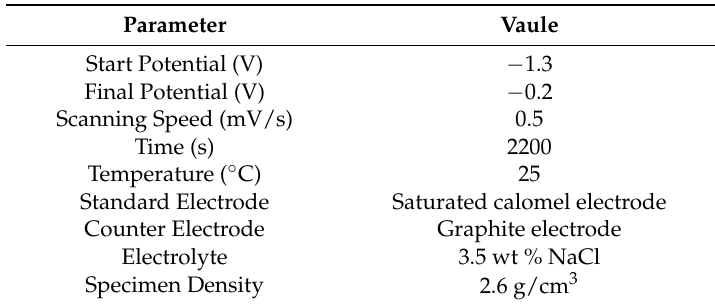
Table 2. Polarization test